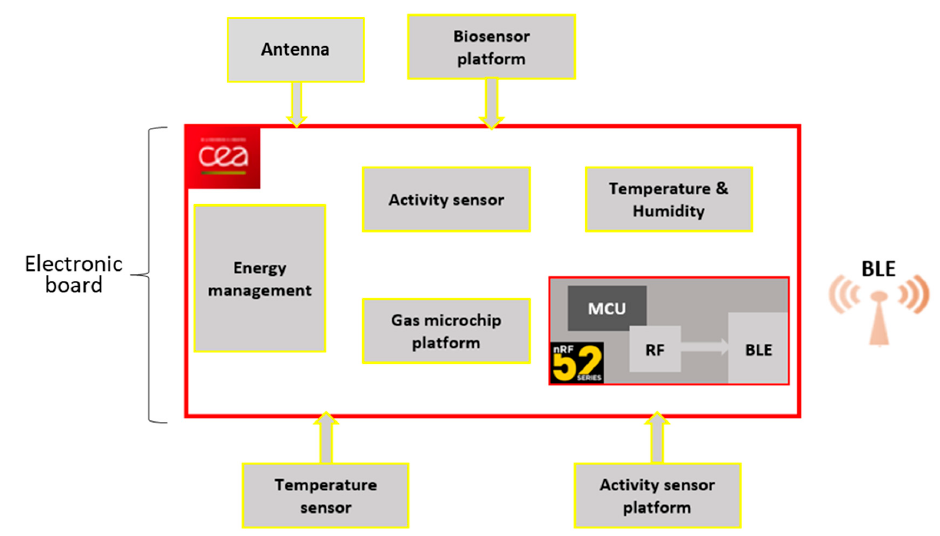
Figure 1. Low-power sensing platform simplified design. The red rectangle represents the electronic board integrating the MCU, the BLE, energy management and some sensors. Other sensors can be connected to the board.